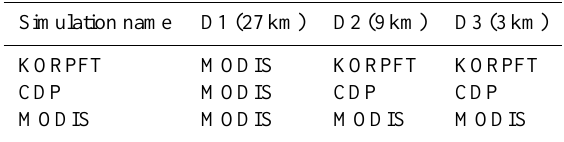
Table 1. List of model simulation scenarios and the PFT data sets used for biogenic emissions